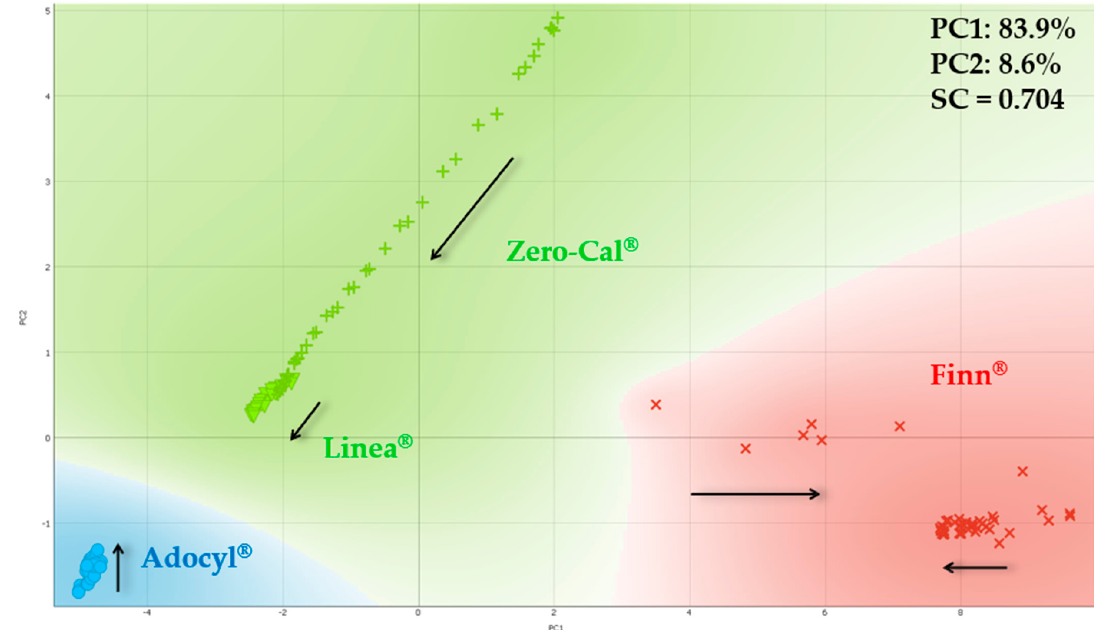
Figure 11. PCA plot for distinct brands of sucralose-based sweeteners in aqueous solutions (10 µL/mL) obtained using the impedimetric microfluidic e-tongue from 0 to 10 mL/h flow rates. The arrows indicate the direction of the increasing flow rate.